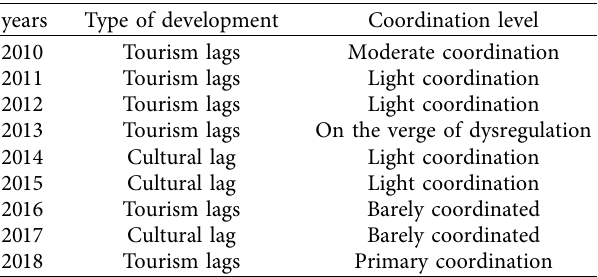
Figure 9: Evaluation indicators of cultural and tourism industry integration. Table 5: Level of integration of cultural and tourism industries from 2010 to 2018.